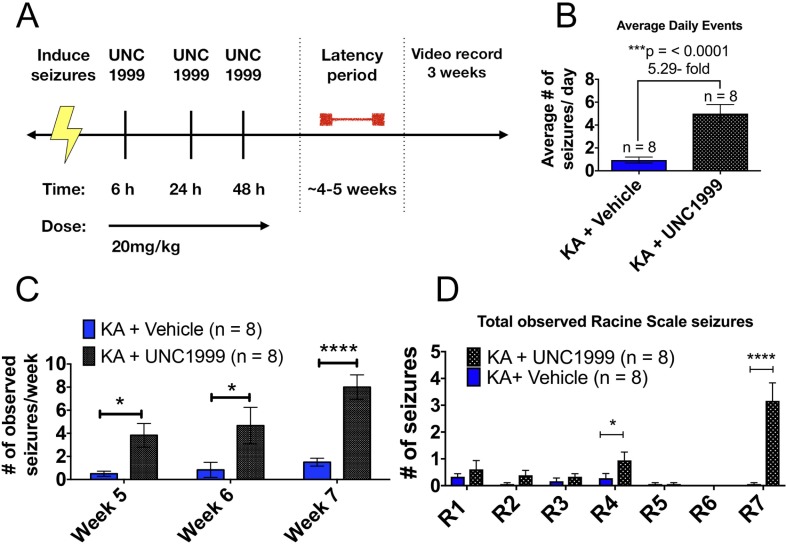
Inhibition of EZH2 in vivo increases seizure burden in KA treated mice.(A) Schematic of UNC1999 dosing regimen used with KA to test animals. Briefly, animals were induced to SE and then dosed three times with 20mg/kg UNC1999 at 6, 24 and 48 hours. Animals were allowed to recover for 4–5 weeks and then scored through video monitoring for 3 weeks. Two observers blinded to treatment groups scored all videos. (B) KA + UNC1999 exhibited 5.29-fold more average seizures per day compared to vehicle treated animals (Student’s unpaired t-test with equal SD, p <0.05). (C) KA+ UNC1999 treated animals demonstrate significantly greater number of seizure events per week of recording compared to vehicle treated mice (Two-way ANOVA test, p< 0.05, with Holm- Sidak correction). (D) KA + UNC1999 treated mice exhibited significantly more rearing and running, jumping and spinning in circles behavior compared to vehicle, suggesting a more severe disease progression. Statistical significance assessed by Student’s unpaired t-test with equal SD (p < 0.05), n = 6 saline + vehicle, n = 3 KA + vehicle and n = 7 KA + UNC1999 animals. *p <0.05, **p < 0.01, ***p< 0.001, ****p <0.0001.